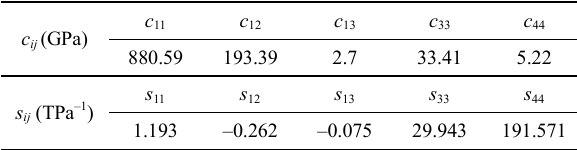
Table 7 Elastic constants and compliance coefficients of h-BN at room temperature, P = 0